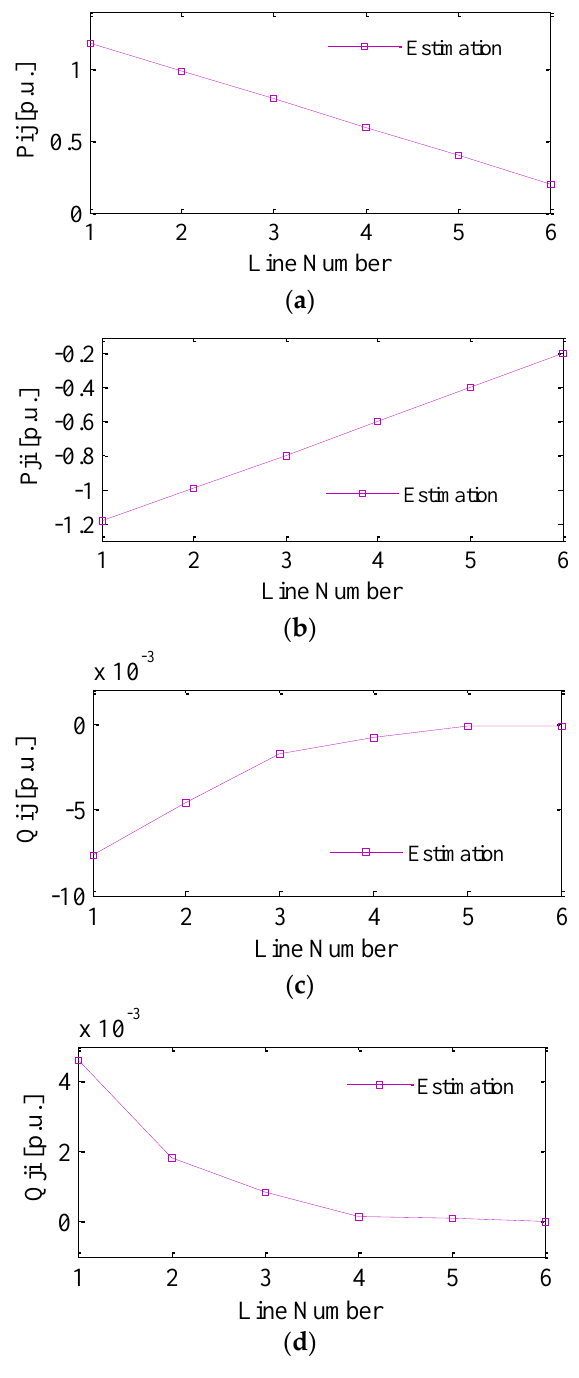
Figure 7. Line estimation using the adaptive tolerant estimator ( a ) P ij ; ( b ) P ji ; ( c ) Q ij ; ( d ) Q ji . The comparative results of line estimation using the conventional adaptive estimator and adaptive tolerant estimator are shown in Figure 8 for rapid changes in the parameters. Compared to the adaptive tolerant estimator, the conventional adaptive estimator increases the line estimation errors under the condition of model uncertainty caused by rapid parameter changes. The errors of line measurement data happen in the P ij , P ji , Q ij and Q ji estimations. The deviations are large for Q ij and Q ji , which affects the estimation results and power quality. These deviations remain in the estimation process, causing greater errors in the front of the distribution network, which reduces the estimator